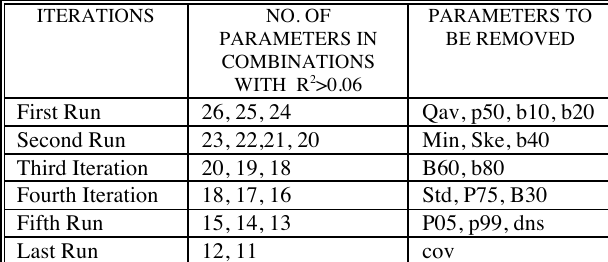
Figure 7: Estimated mean DBH and measured mean DBH per grid